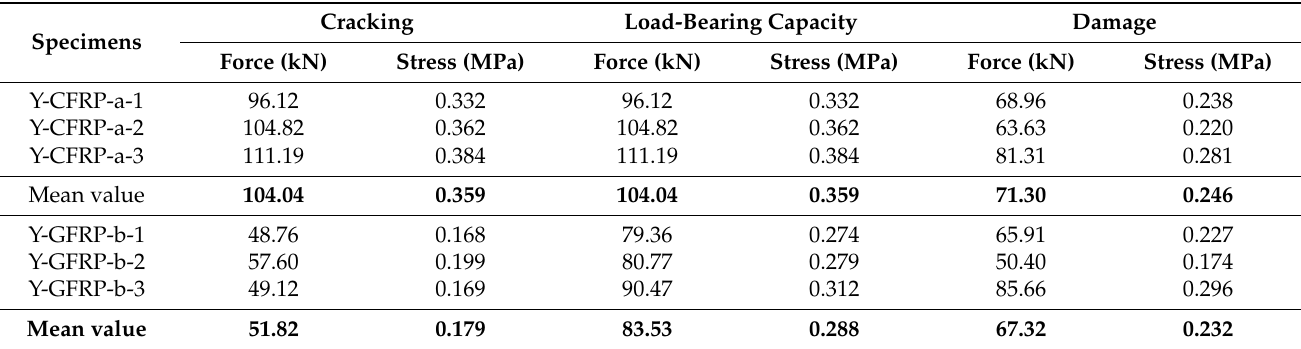
Table 7. Specific forces and stresses characterizing the walls strengthened in configuration ‘b’.